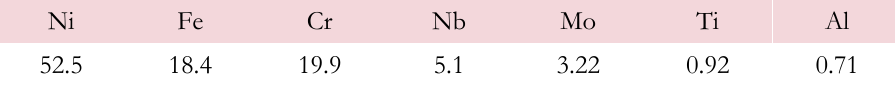
Table 1: Chemical composition in wt.